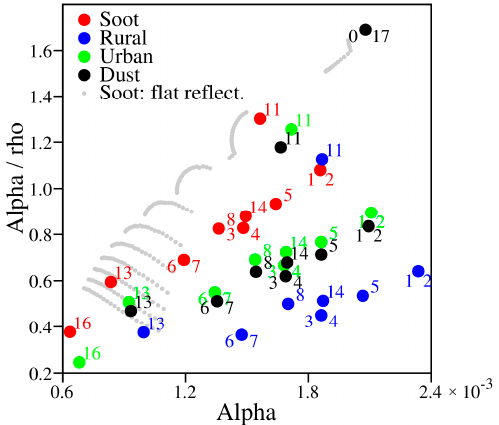
Figure 13. Correlation diagram between α a and α a /ρ a based on simulations, assuming various surface types: red, Soot; blue, Rural; green, Urban; black, Dust-like. Numbers adjacent to each dot represent the land cover type: 0, water; 1, evergreen needleleaf forest; 2, evergreen broadleaf forest; 3, deciduous needleleaf forest; 4, deciduous broadleaf forest; 5, mixed forest; 6, closed shrublands; 7, open shrublands; 8, woody savanna; 9, savanna; 10, grasslands; 11, permanent wetlands; 12, croplands; 13, urban and built-up areas; 14, cropland/natural; 15, snow and ice; 16, barren or sparsely vegetated areas; 17, water bodies; and 18, tundra. Gray dots show results for Soot obtained from a simulation in which the surface albedo varies from 0.05 to 0.5, but it was the same for all GOSAT spectral bands. For land cover types of ‘0, water’, ‘17, water bodies’, ‘15, snow and ice’, and ‘18, tundra’, values of α a or α a / ρ a are so large that they exceed the axis range. They are not shown in Figure 13. As the results for ‘9, savanna’, ‘10, grasslands’, and ‘12, croplands’ are overlapping with ’8, woody savanna’, only a label for ‘8’ is plotted on the figure.